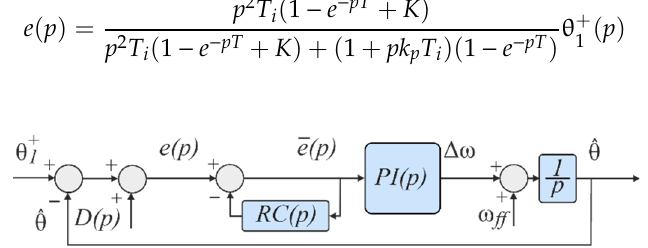
Figure 3. Bode plots of moving average filter (MAF) and repetitive control filter (RCF) (parameters are selected according to Table 2).